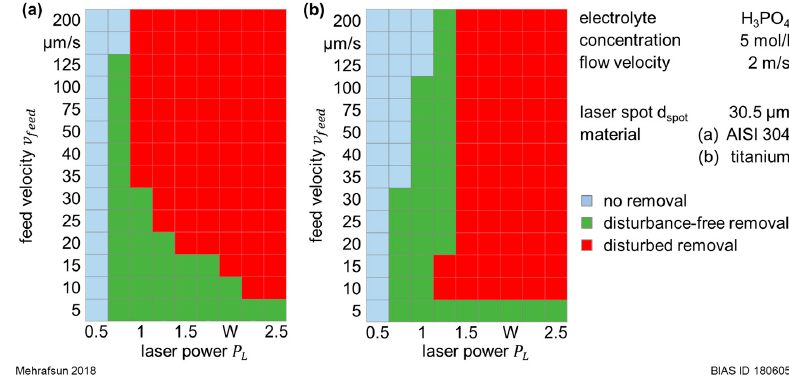
Figure 4. Experimentally determined LCM removal regimes for ( a ) stainless steel and ( b ) titanium in a 5 ‐ mol/L phosphoric acid solution.